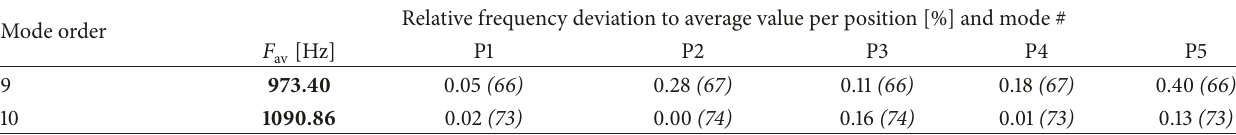
Table 3: Transversal vibration modes at the bar of secondary with displacement along with vertical. Mode order